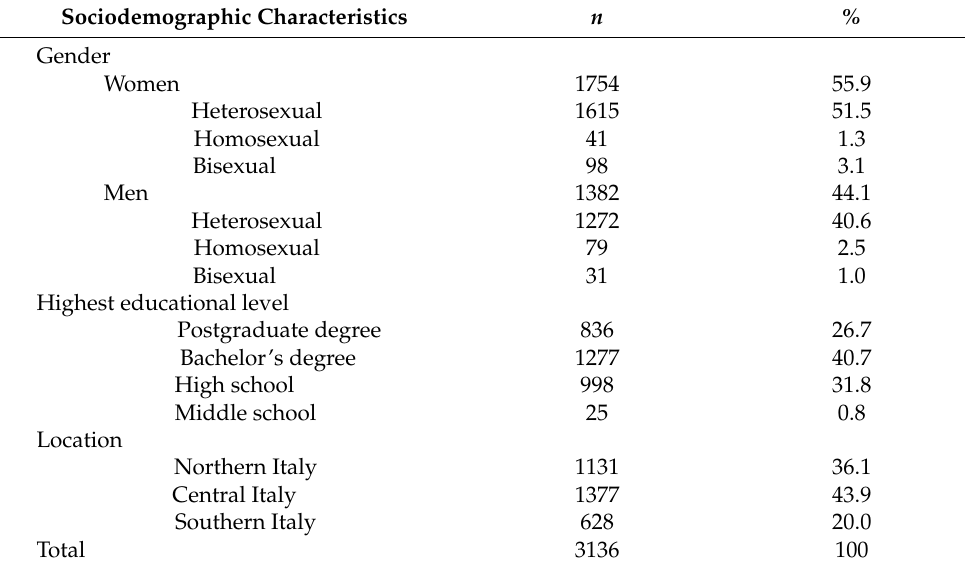
Table 2. Sociodemographic Characteristics of